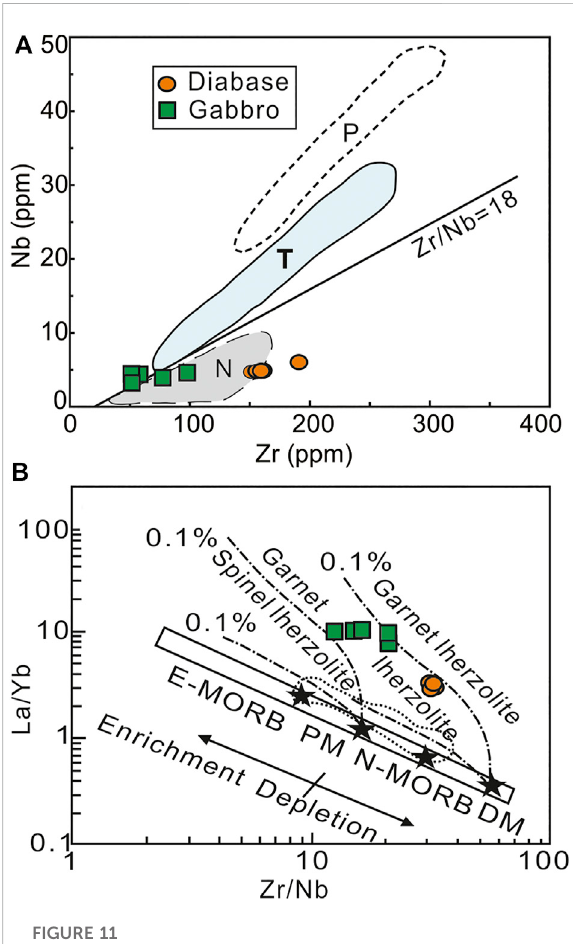
FIGURE 11 Magma source discrimination diagrams for the diabase and gabbro: (A) Nb versus Zr (Le Roex et al., 1983); (B) La/Yb versus Zr/ Nb (Zhao & Zhou, 2007). N – depleted mantle; T – transitional mantle; P – primitive